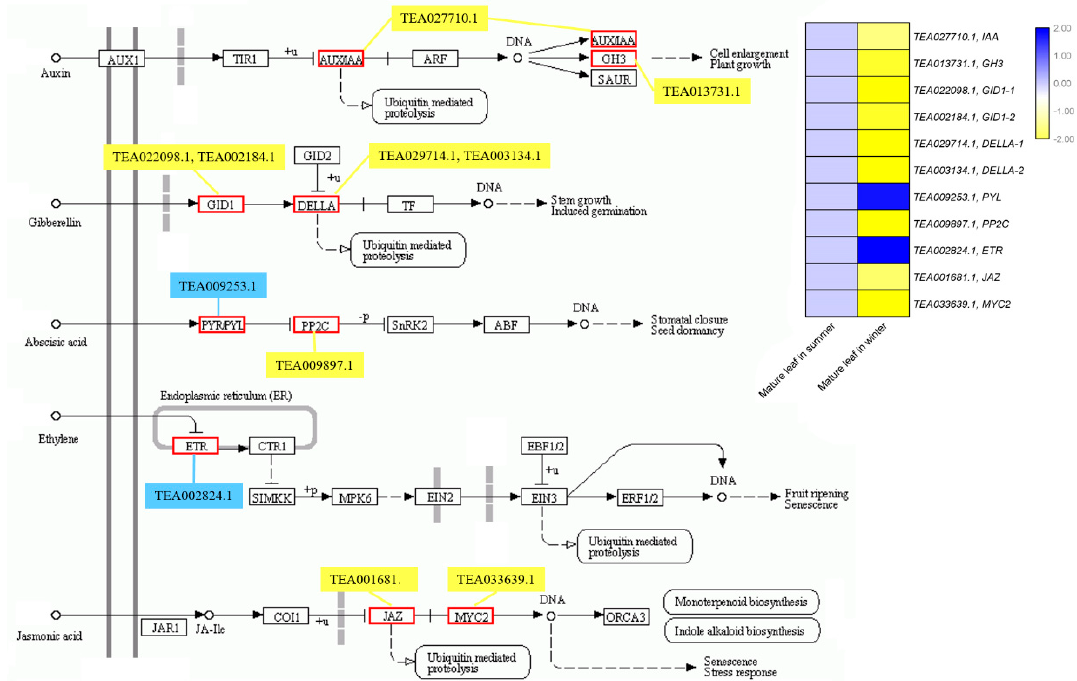
Figure 8. The putative target genes of CsCBFs involved in the plant hormone signaling pathways. The bar color represents the normalized FPKM values. Blue and yellow indicate significant up- and downregulation of target genes, respectively.